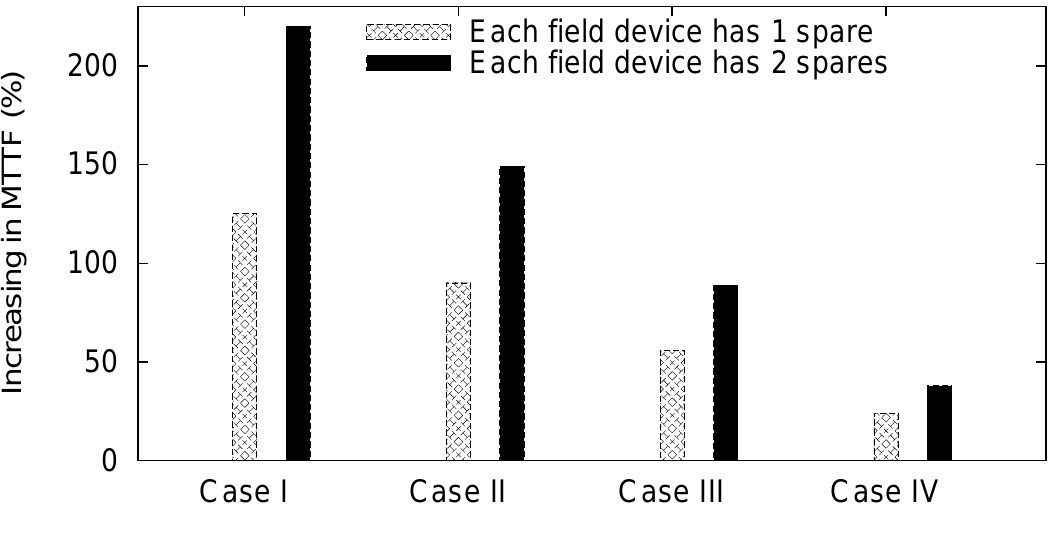
Figure 16. Influence of failure conditions and redundancy levels to the network